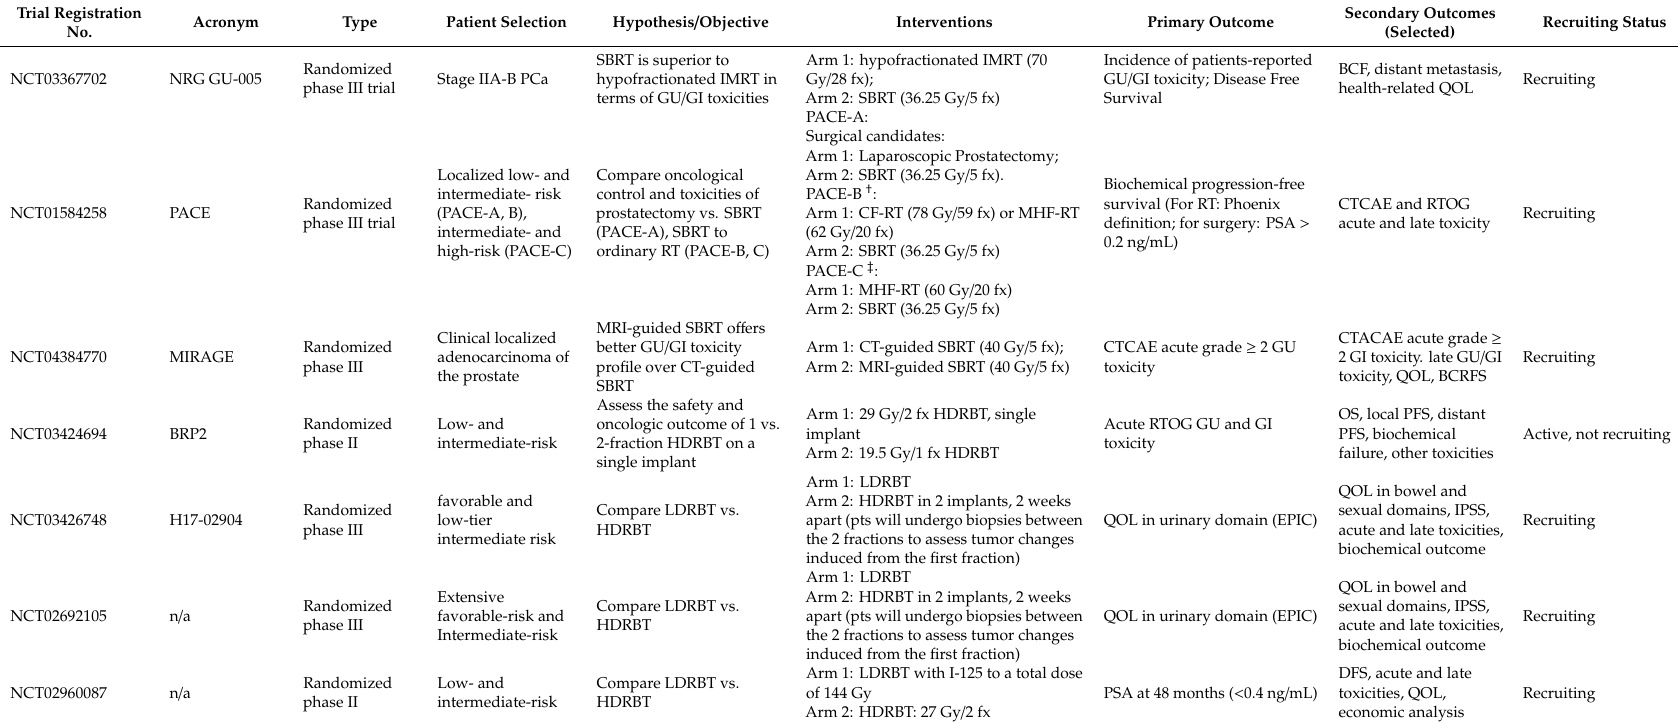
Table 3. Selected list of important ongoing randomized SBRT and HDRBT